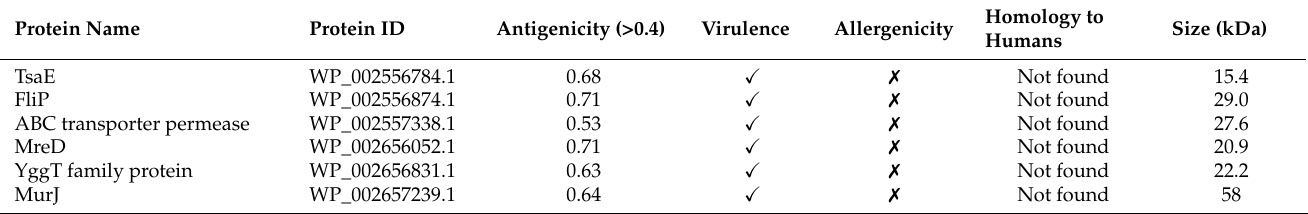
Table 1. Proteins shortlisted for multiple epitope prediction using proteome analysis of B. burgdorgeri .